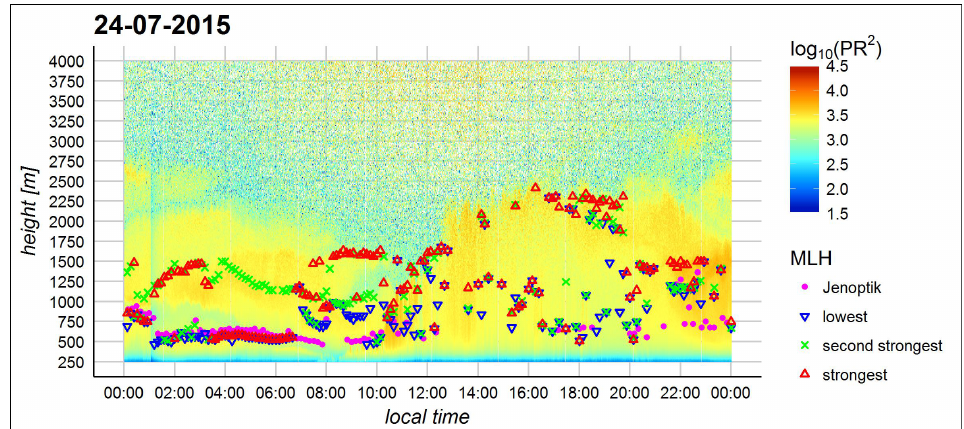
Figure 6. Time-height cross section of the ceilometer’s range-corrected backscatter power (PR 2 in arbitrary units) on 24 July 2015. The MLH calculated by the Jenoptik algorithm (magenta dots) and STRAT’s candidates (the strongest gradient—red triangles, the second strongest gradient—green “x” marks, and the lowest gradient—blue upside down triangles) are also shown.